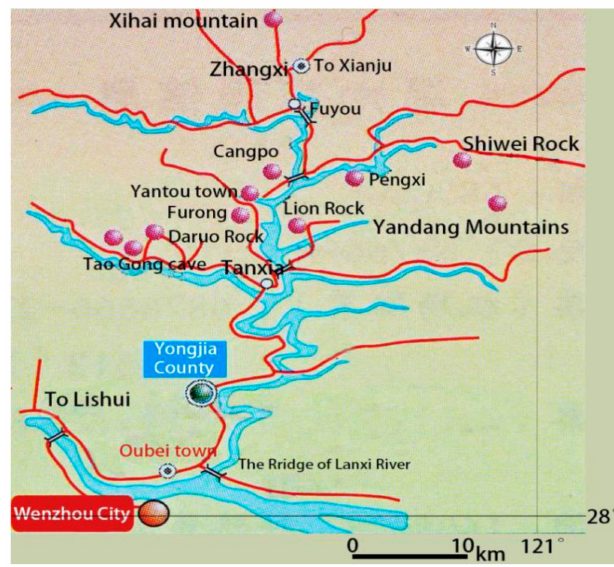
Figure 1. Nanxi River, Zhejiang